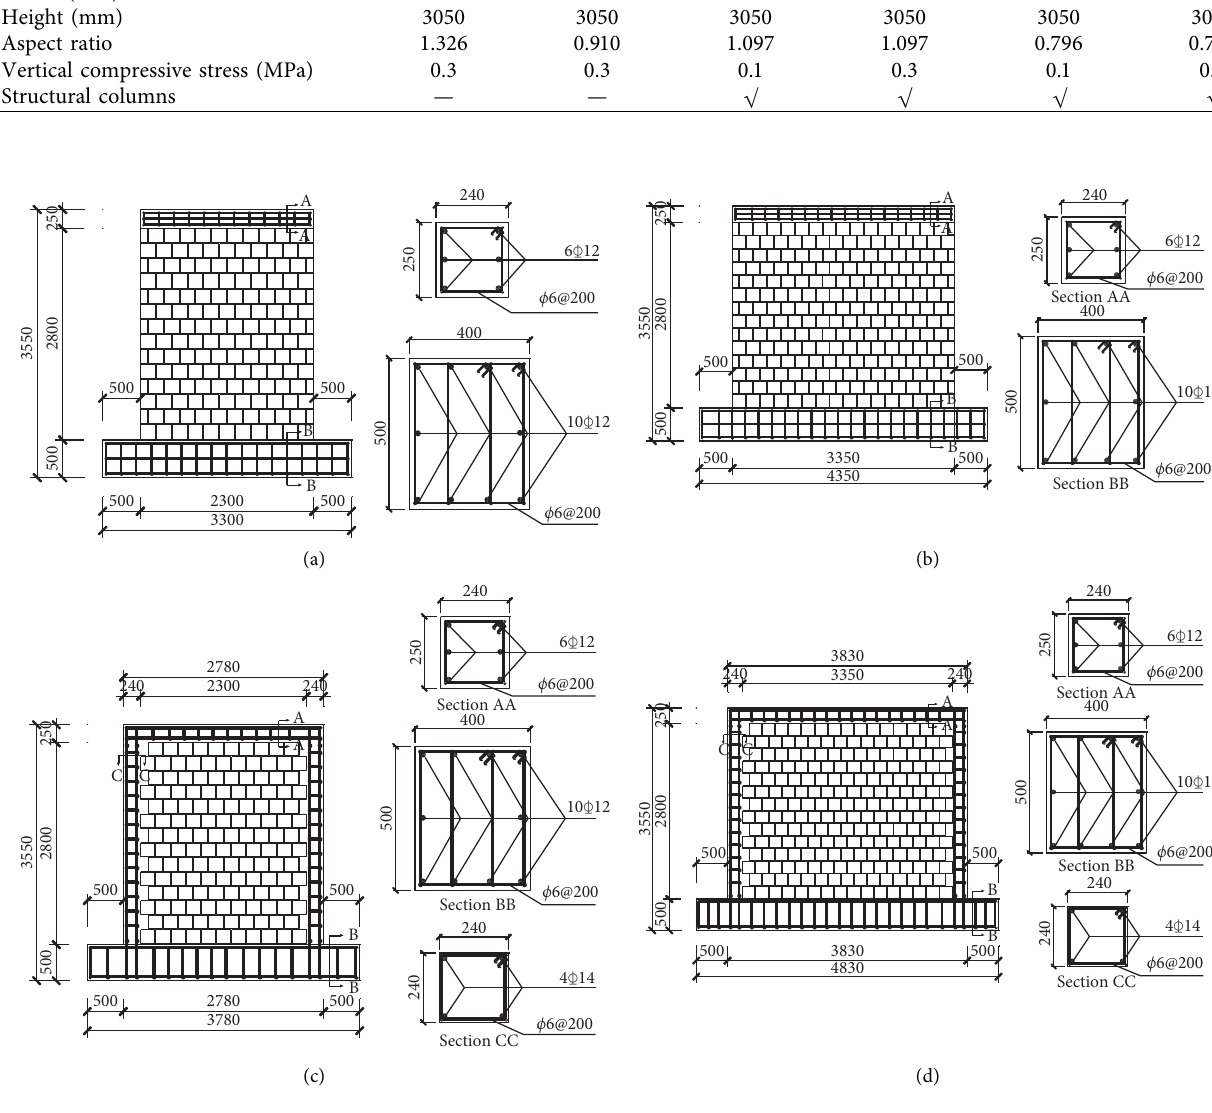
Figure 3: Design details of specimens. (a) W1; (b) W2; (c) W3 and W4; (d) W5 and